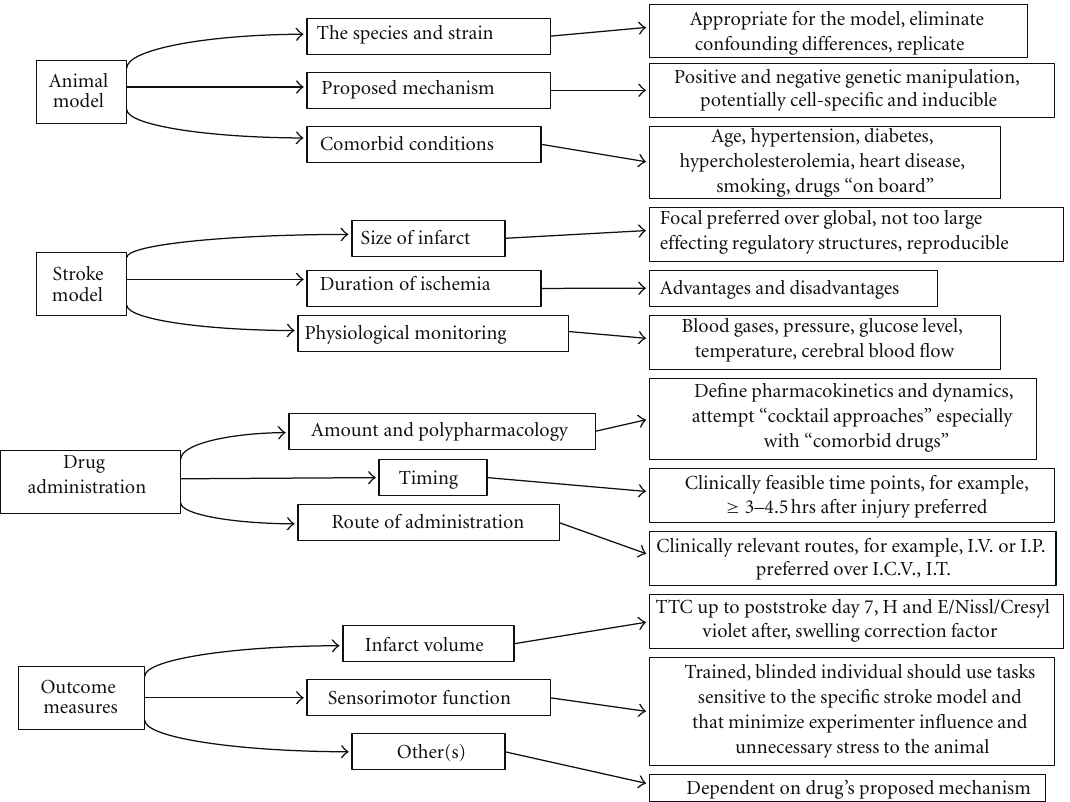
Figure 1: Summary of considerations for successfully climbing the